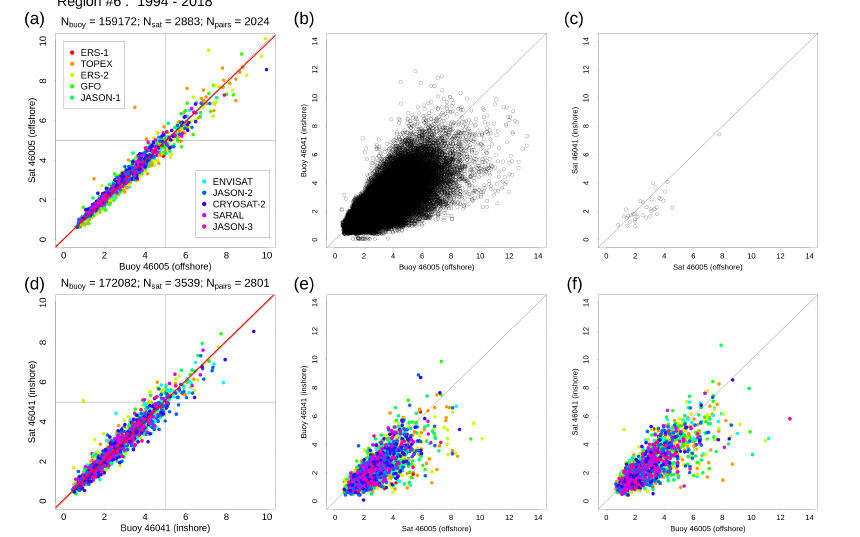
Figure 9. Scatter plots for pairwise 1-h observations in region #6, at 46005 (offshore) and 46041 (nearshore) for combinations of source data and locations. ( a , d ) show Sea State CCI L2P vs. buoys 46005 and 46041 respectively. Red lines ( a , b ) show the fit of linear major-axis regression models to the entire data set. ( b , c , e , f ) show comparisons of the remaining combinations of source data and location. Colouring by mission is applied to selected panels where this makes